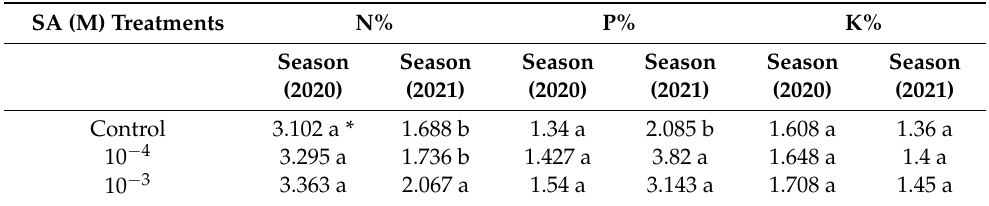
Table 7. Effects of SA concentration on nitrogen (N), phosphorus (P), and potassium (K) percentages in C. longa